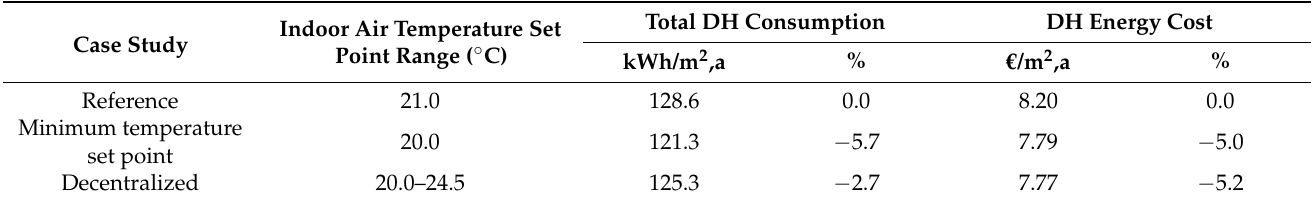
Table 4. DH consumption and cost per year by using the decentralized DR